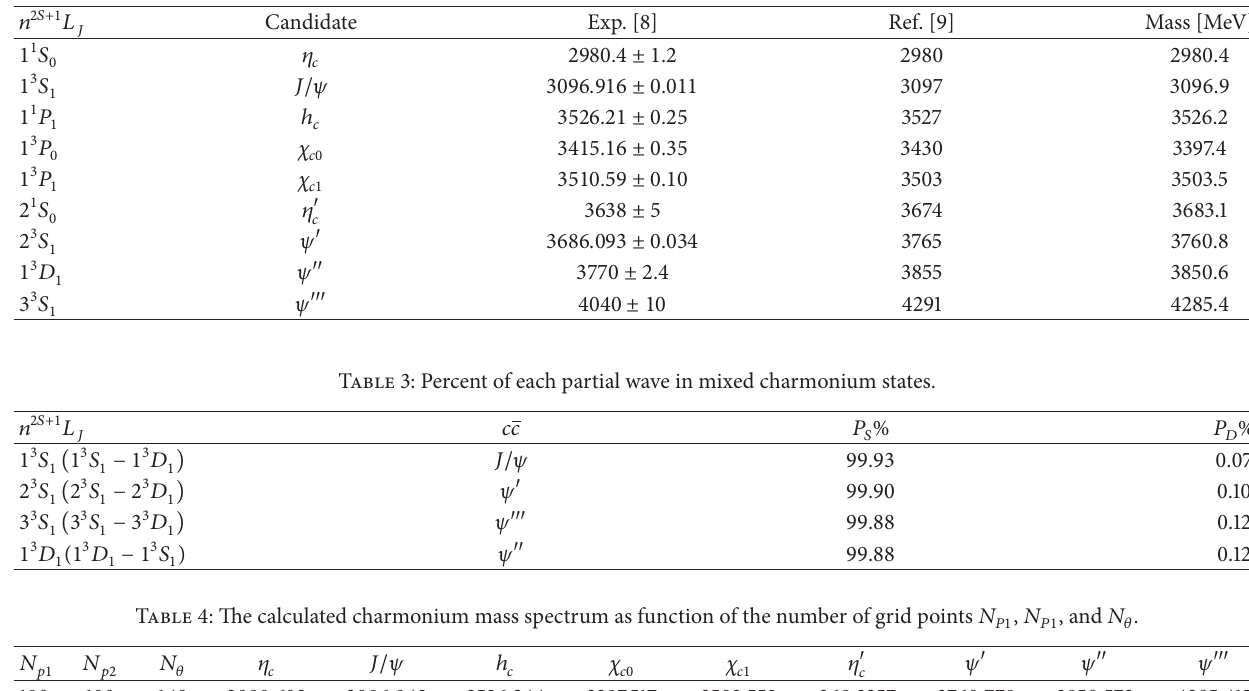
Table 2: Comparison of the obtained charmonium mass spectrum with the experimental data and another work.